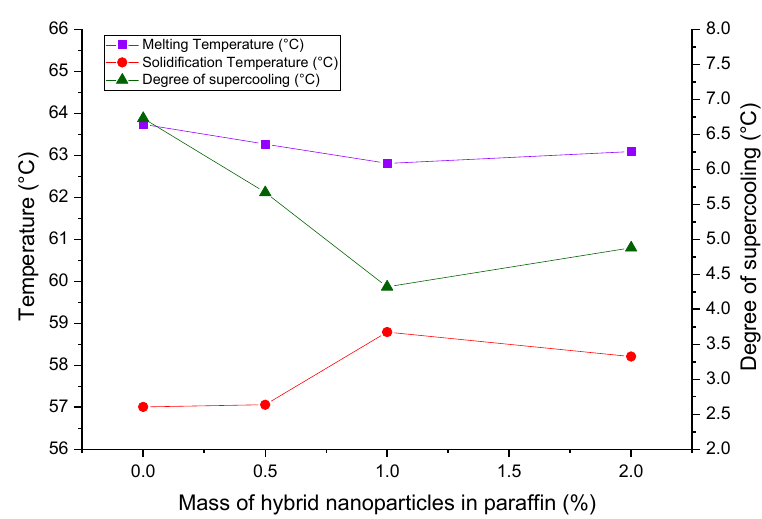
Figure 6. Variation in melting temperature, solidification temperature and degree of supercooling of